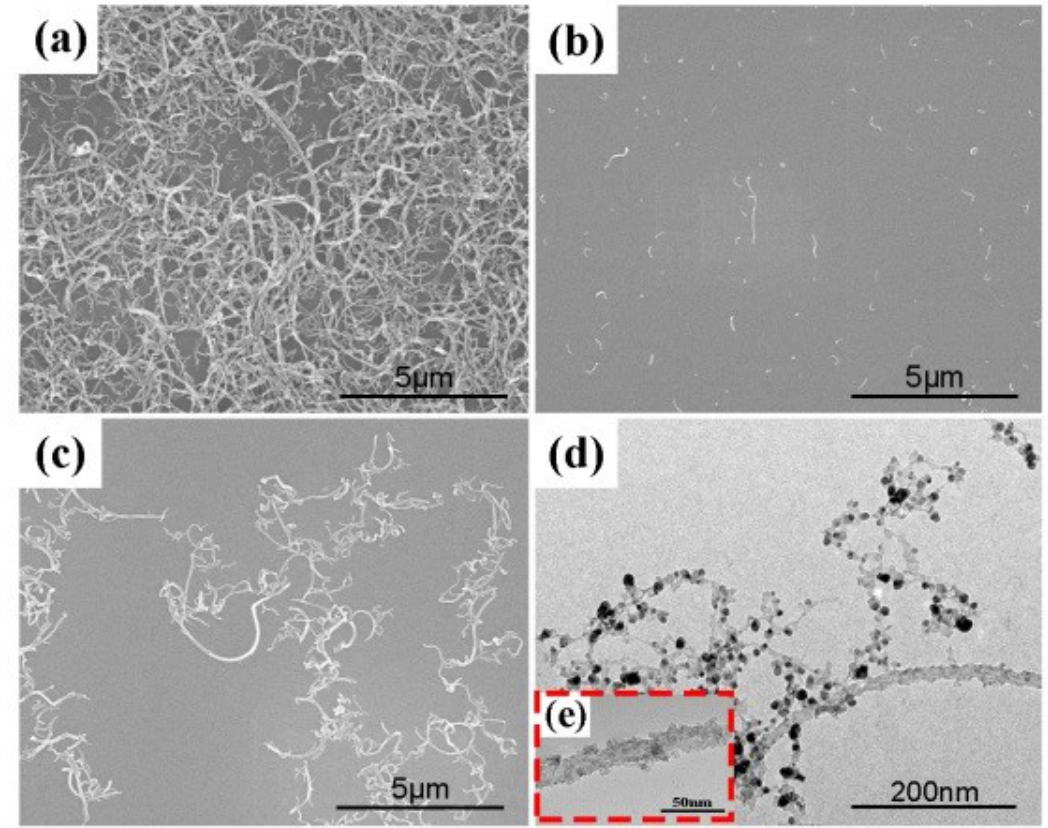
Figure 2. Effects of EPUSA on the dispersion of CNTs, ( a ) the CNTs before EPUSA; ( b ) CNTs of 2 min with EPUSA; ( c ) CNTs of 5 min with EPUSA; ( d ) TEM image of Ag@CNTs composites prepared by EPUSA and ( e ) TEM image of Ag@CNTs.